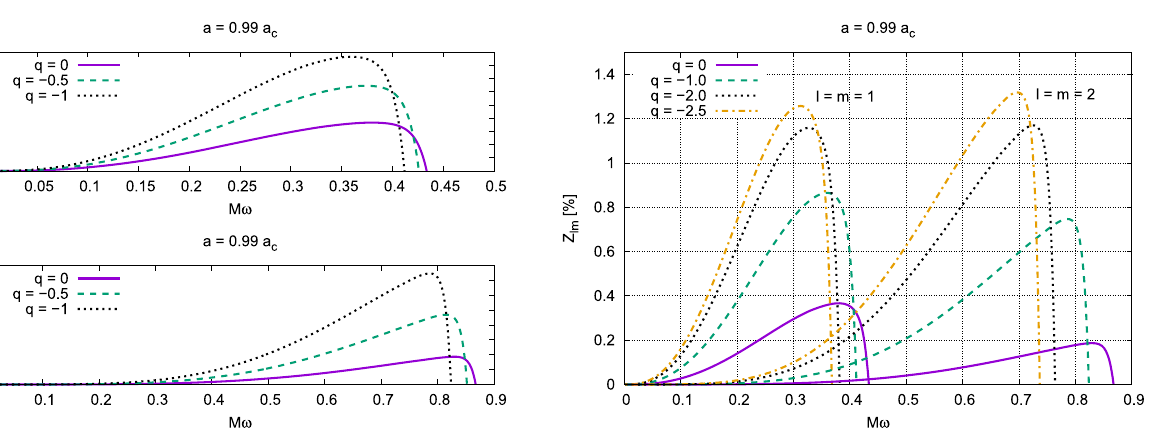
case exceeds the one of modes l = m = 1 for q around − 2.